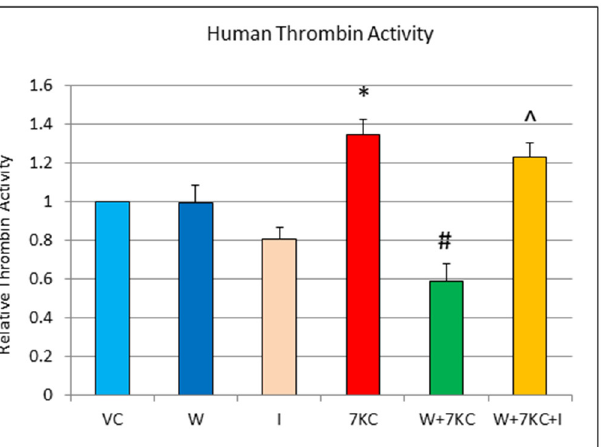
Figure 7. Effect of withanolide A and 7KC on human thrombin activity. Significant increase in throm- bin activity was observed after treatment of cells with 7KC. This increase was significantly reduced by withanolide A. The modulatory effect of withanolide A against increase in 7KC induced thrombin activity was abolished when cells were co-treated with withanolide A and mifepristone together with 7KC. Data are represented as mean ± SD ( n = 4). * Significant difference compared to controls. # Significant difference compared to 7KC ˆ Significant difference compared to withanolide A + 7KC (all p <